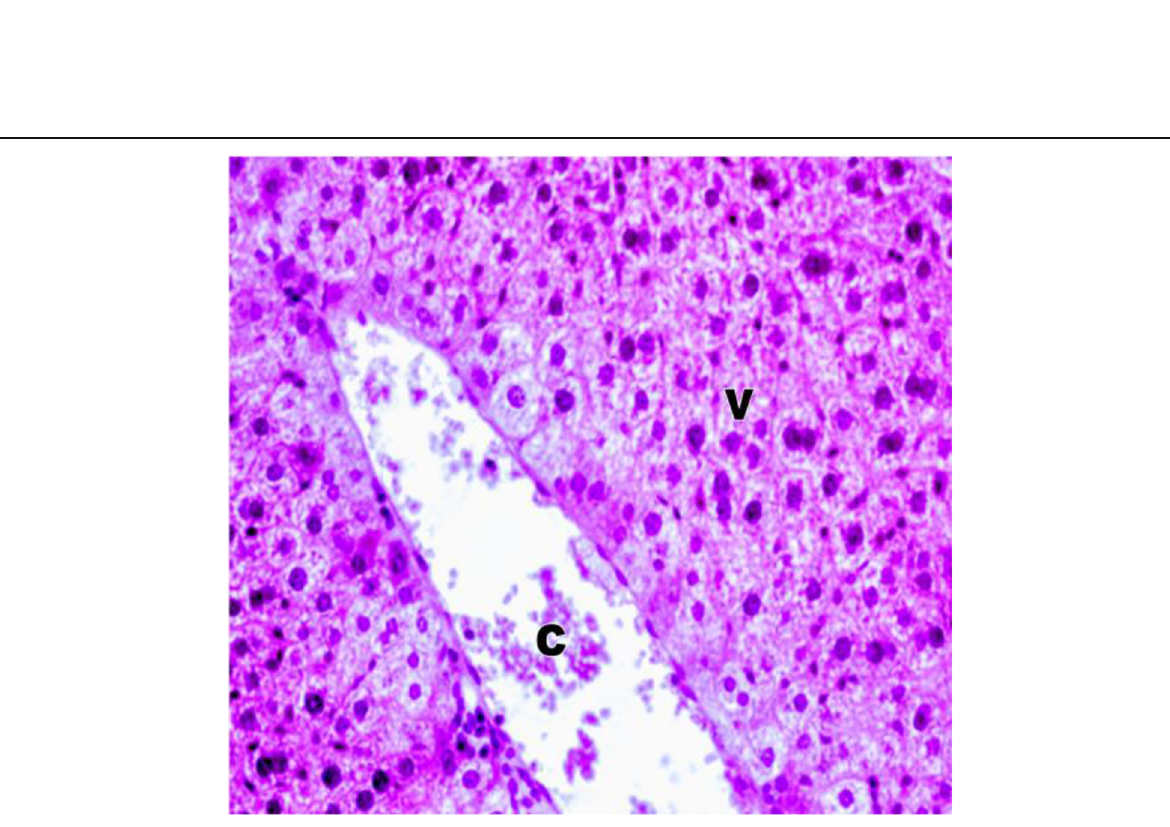
Fig. 9 Photomicrograph of a section of the liver of treated mouse with Tamiflu (16 mg/kg b.wt.) in addition to Adamine (20 mg/kg b.wt.) for 5 days revealing hepatocytes with cytoplasmic vacuolation (V) and enlargement of central vein (C) containing blood cells. (H&E, × 400)